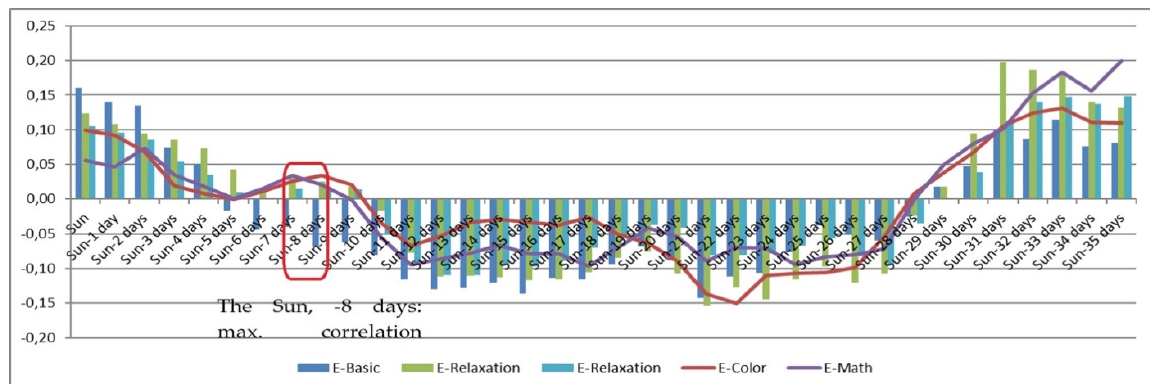
Figure 6. The correlation dependency of the psychophysiological parameter B (BVP LF % power mean) on the intensity of solar activity.